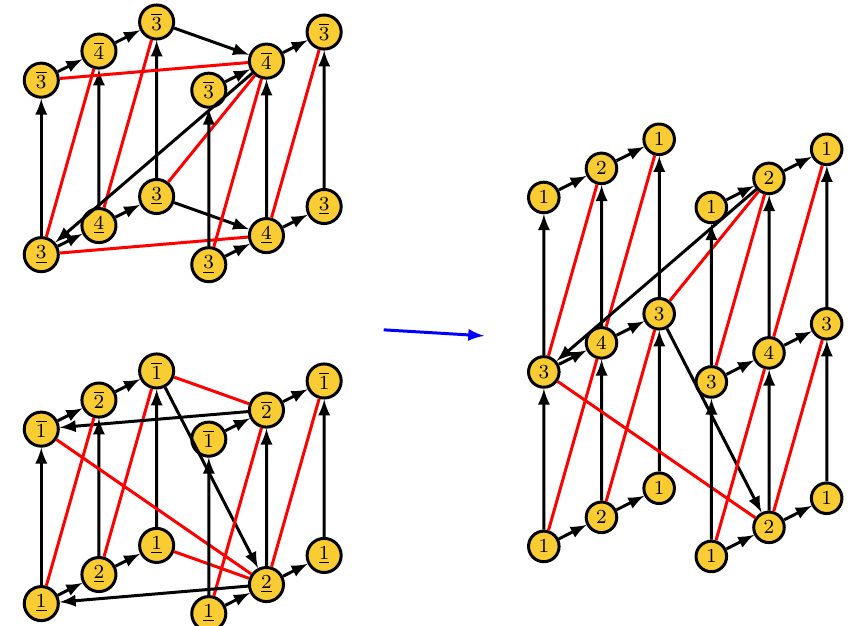
Figure 21. 3 d printing of an inconsistent periodic quiver for D 3